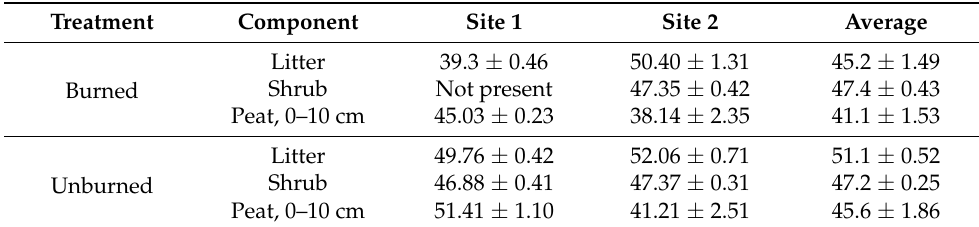
Table 2. Carbon content (C%) of measured above- and belowground components in burned and unburned degraded peatland treatments according to site. Treatment